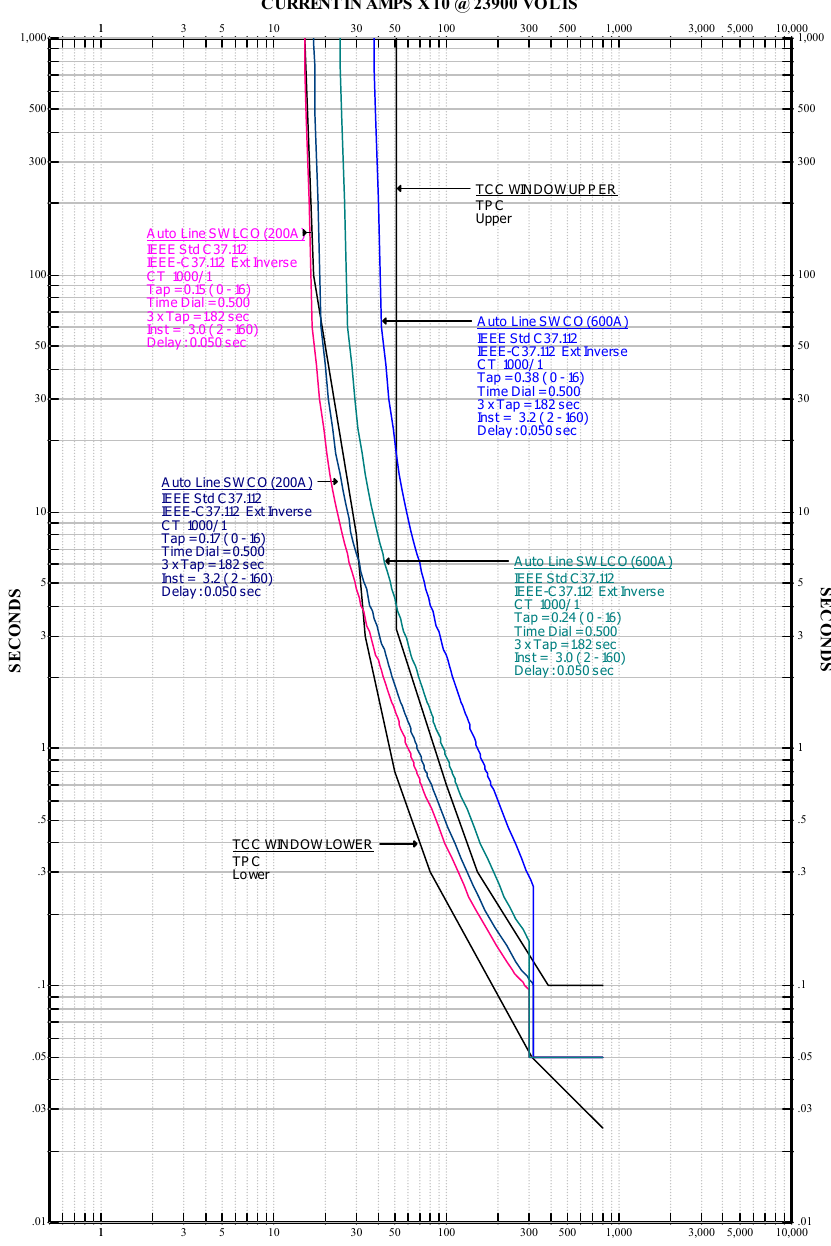
Figure 3. Proposed automatic line switch CO and LCO relays time current characteristic